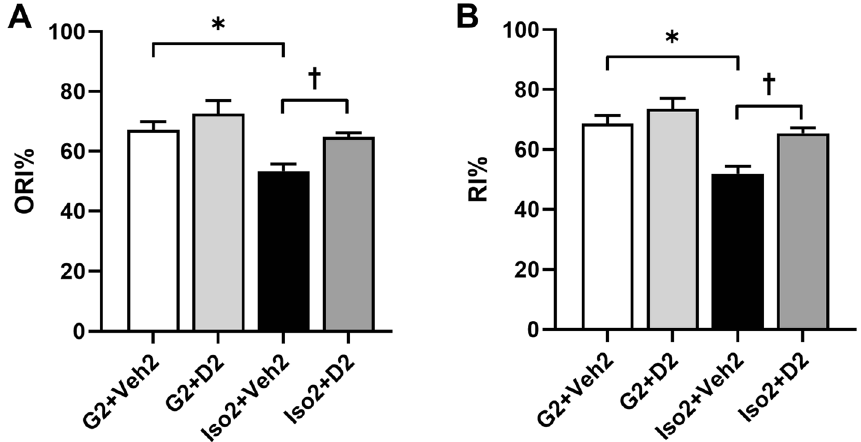
Figure 1. Cognition-related behaviors. ( A ) Novel object recognition. ORI = object recognition index. ( B ) Novel context recognition. RI = recognition index. G2 + Veh2: 2-week grouped plus 2-week grouped with vehicle treatment; G2 + D2: 2-week grouped plus 2-week grouped with DHM treatment; Iso2 + Veh2: 2-week SoIso plus 2-week SoIso with vehicle treatment; Iso2 + D2: 2-week SoIso plus 2-week SoIso with DHM administration. Bars represent mean ± SEM. Two-way ANOVA followed by multiple comparisons with Holm-Sidak method. *, P ≤ 0.05. †, P ≤ 0.05 vs Iso2 +